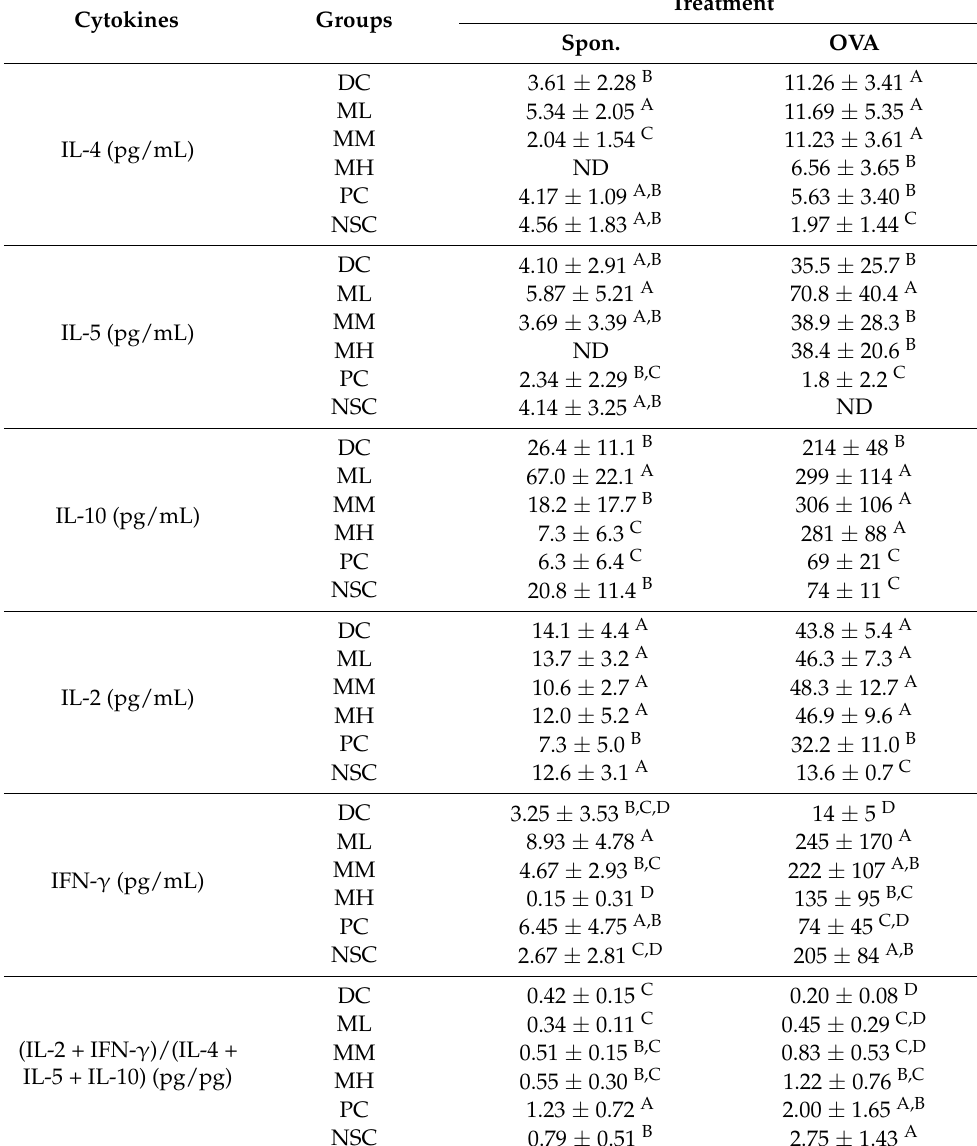
Table 6. Effects of menthone inhalation with different doses on Th1 and Th2 cytokine secretion profiles by splenocytes of OVA/Al-sensitized and challenged BALB/c asthmatic mice. Cytokines Groups